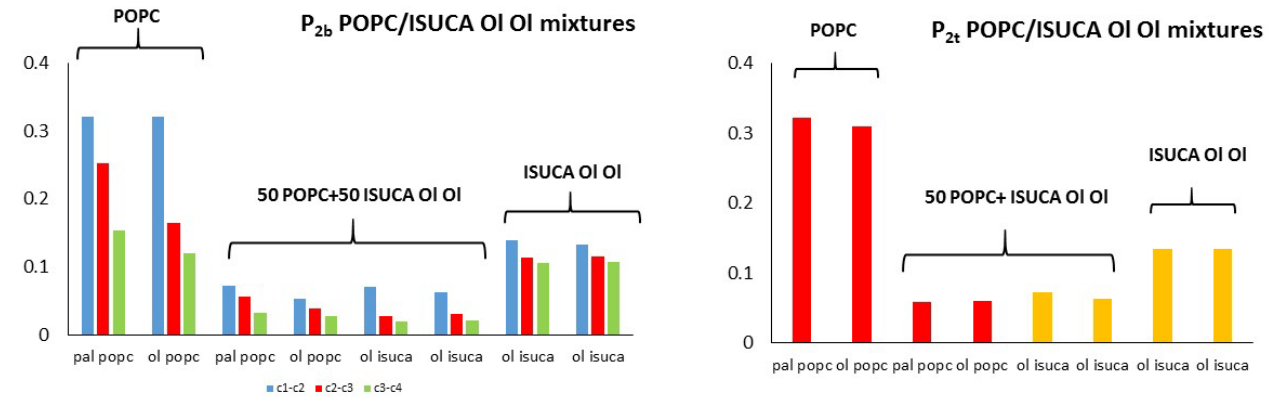
Figure 9. P 2t and P 2b for POPC/ISUCA-Ol Ol mixtures.